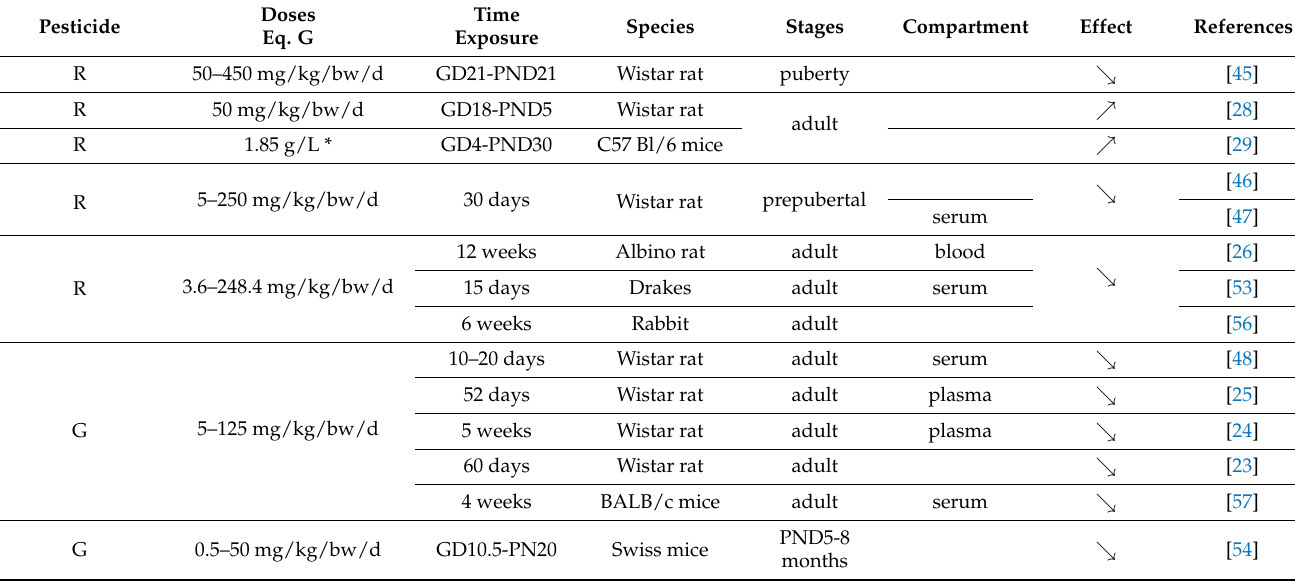
Table 4. Summary of in vivo studies of G or GBH exposure impact on testosterone secretion. * drinking water; Eq: equivalent. Numbering in brackets indicates references.